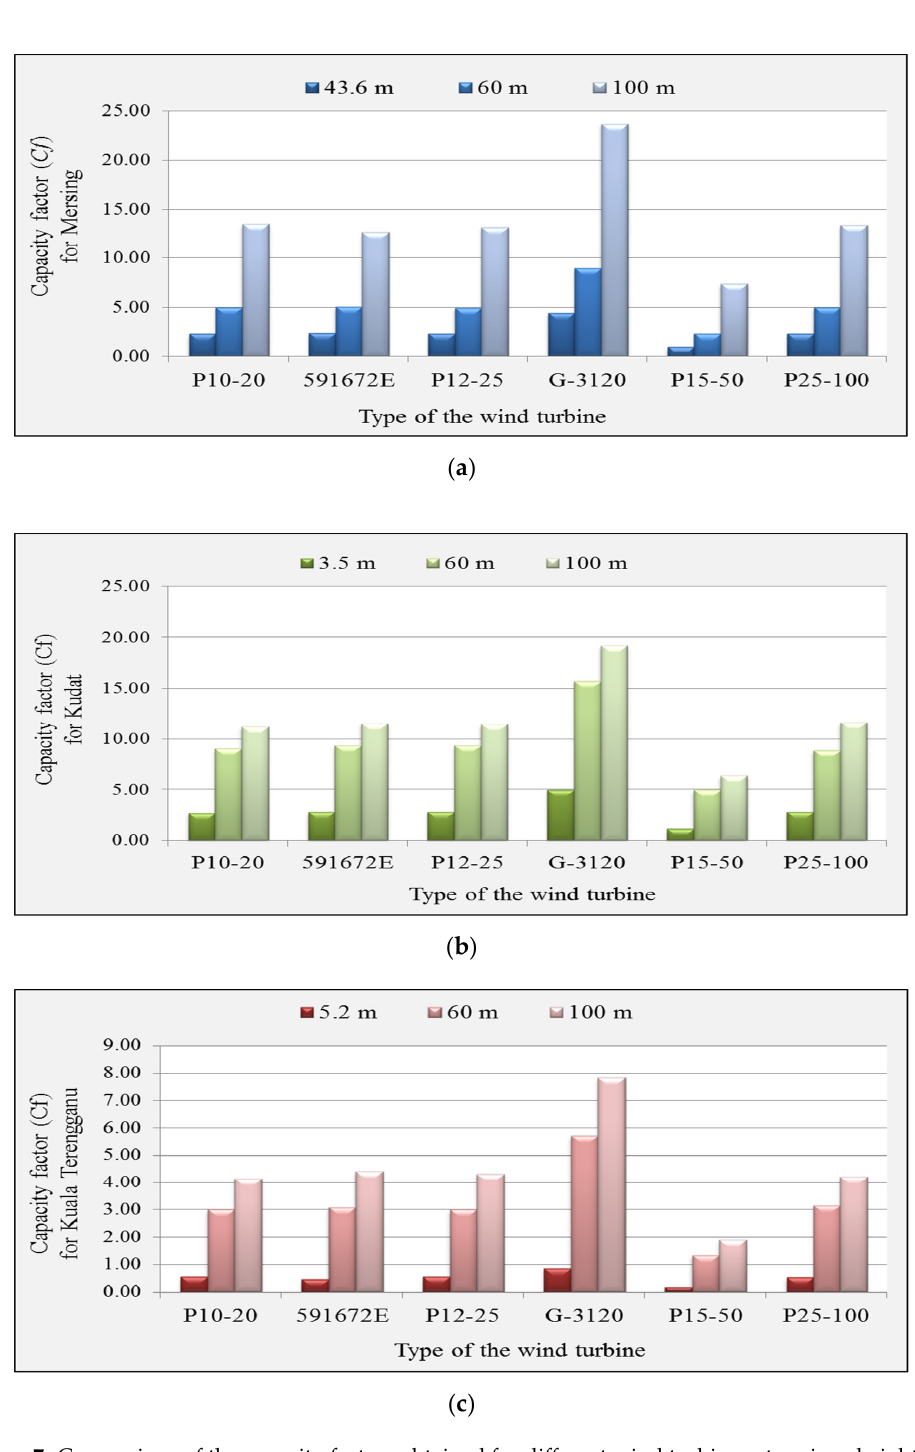
Figure 7. Comparison of the capacity factors obtained for different wind turbines at various heights for sites ( a ) Mersing, ( b ) Kudat, and ( c ) Kuala Terengganu.